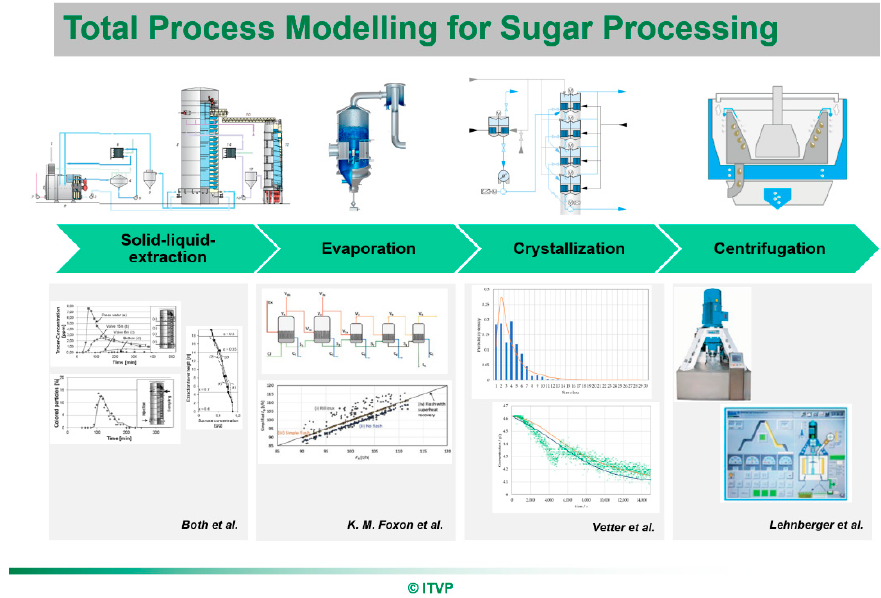
Figure 1. Visualization for the total process modeling the sugar production process.